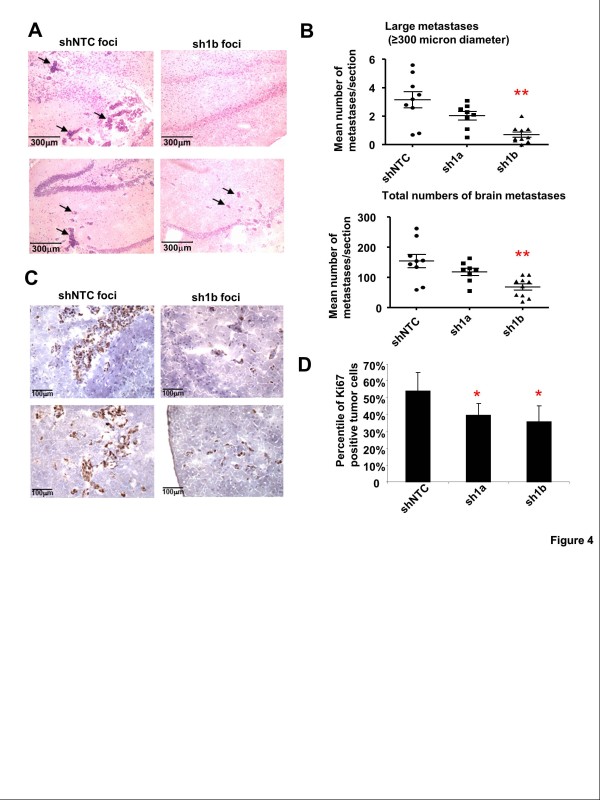
MMP-1 knockdown in 231-BR cells attenuates brain metastasis. MMP-1 shRNA expressing 231-BR cells, sh1a and sh1b, and control shNTC cells were injected into the left heart of nude mice, 1.75×105 cells per mouse. Each group includes ten mice. Mice were sacrificed after 4 weeks and the number of experimental metastases scored in serial brain sections. A, Representative H&E staining of brain sections. Arrows indicate metastatic foci. B, The sh1a and sh1b cells formed fewer large metastases and total metastases compared with the control shNTC cells. The data were combined from two independent experiments, shown as the mean and SEM of metastases scored in serial sections. Asterisks indicate that sh1b cells formed significantly fewer large and total metastases compared with shNTC cells (P = 0.002, P = 0.0067 respectively, ANOVA Dunnett’s Multiple comparison test). C, Ki-67 stained sections of brain metastases formed by injection of 231-BR control cells and MMP-1 knockdown cells and D, comparisons of Ki-67 positive cells in brain metastases. Significantly fewer Ki-67 positive cells were found in brain metastases of sh1a (P = 0.022) and sh1b (P = 0.011, Student’s t-test) compared with metastases of shNTC cells.